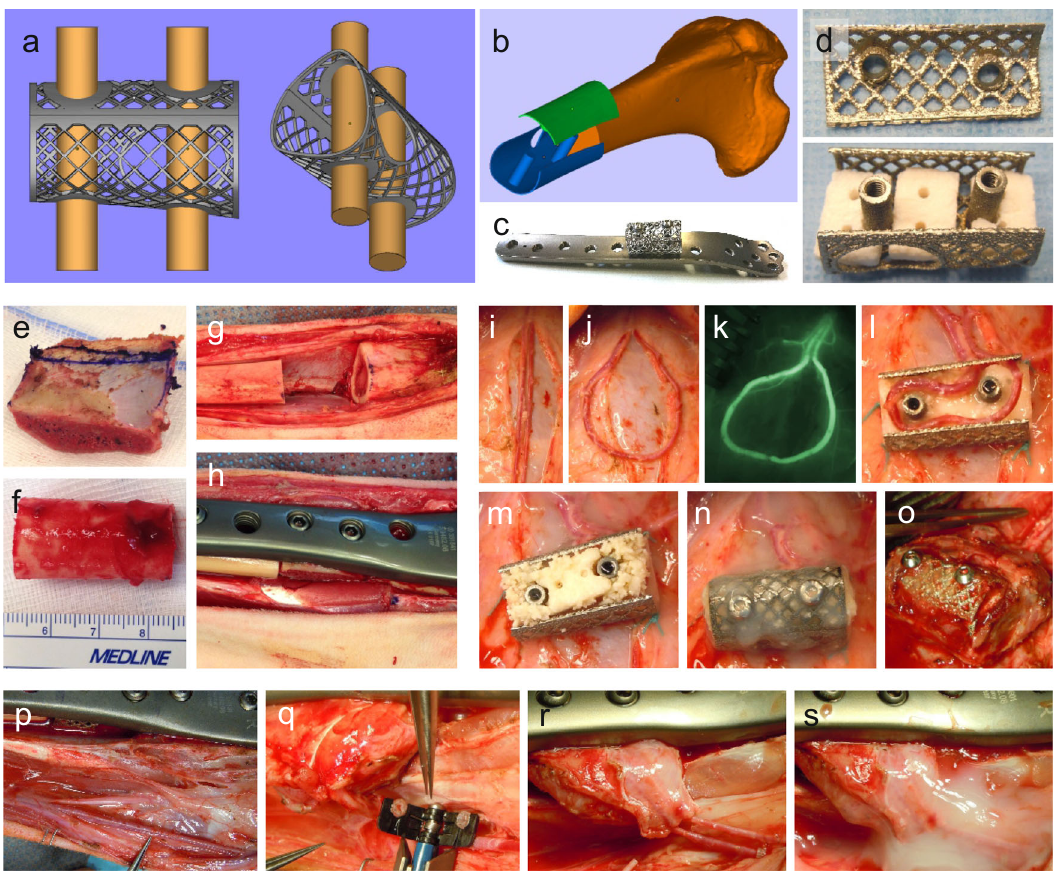
Fig. 6 Surgery. Custom-made perforated titanium chamber for implantation into the sheep tibia defect. a , b Schema with bottom and lid. c Two connecting nuts for stable connection of the lid with the bottom of the chamber and for fi xation at the osteosynthesis plate. d Chamber half- fi lled with the bone substitute NanoBone ® block. For implantation, a fourth block was placed on top of the middle bone block and gaps were completely fi lled with NanoBone ® granulate. e Part of the iliac crest after harvesting. f , g A tibia defect of 3 cm was created. h Iliac crest implanted in the tibia defect before fi xation with the plate. i Medial thigh aspect: After dissection of the subcutaneous fatty layer the translucent super fi cial fascia cruris was incised and the vascular axis of the saphenous artery, vein, and nerve exposed. j AV loop was created microsurgically by micro-anastomosis with 9-0 Nylon interrupted sutures. k Perfusion of the AV loop was checked by indocyanine green (ICG) fl uorescence imaging. l Half of the chamber was pre fi lled with a bone substitute, MSC and EPC and growth factors according to the experimental groups, and the AV loop was placed within the custom-made titanium chamber. m The chamber was completely fi lled with the bone substitute. n The lid was closed, the chamber was fi xed in the groin and embedded in fi brin. o Tissue-engineered bone in the titanium chamber after 4 weeks of prevascularization before transplantation. p The vascular axes of the saphenous artery and vein at the bone defect site were exposed before transplantation of the tissue-engineered bone. q During vessel preparation the bone defect was stabilized with the bone defect plate with a place holder (empty chamber). Vein anastomosis was performed by a coupler system. r Tissue-engineered bone is in place in the tibia defect and fi xed with the plate; artery and vein can be visualized. s Pedicle vessels are embedded in fi brin matrix for stabilization